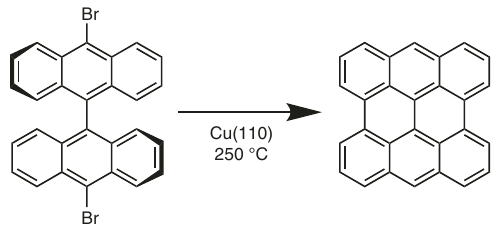
Fig. 1 Surface reaction of 10,10 ′ -dibromo-9,9 ′ -bianthracene (DBBA). Dehalogenation and cyclodehydrogenation of DBBA on Cu(110) resulting in